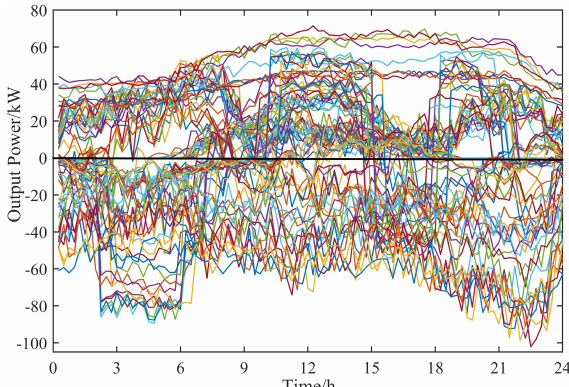
Figure 4. Actual daily output curve of 80 distributed units.